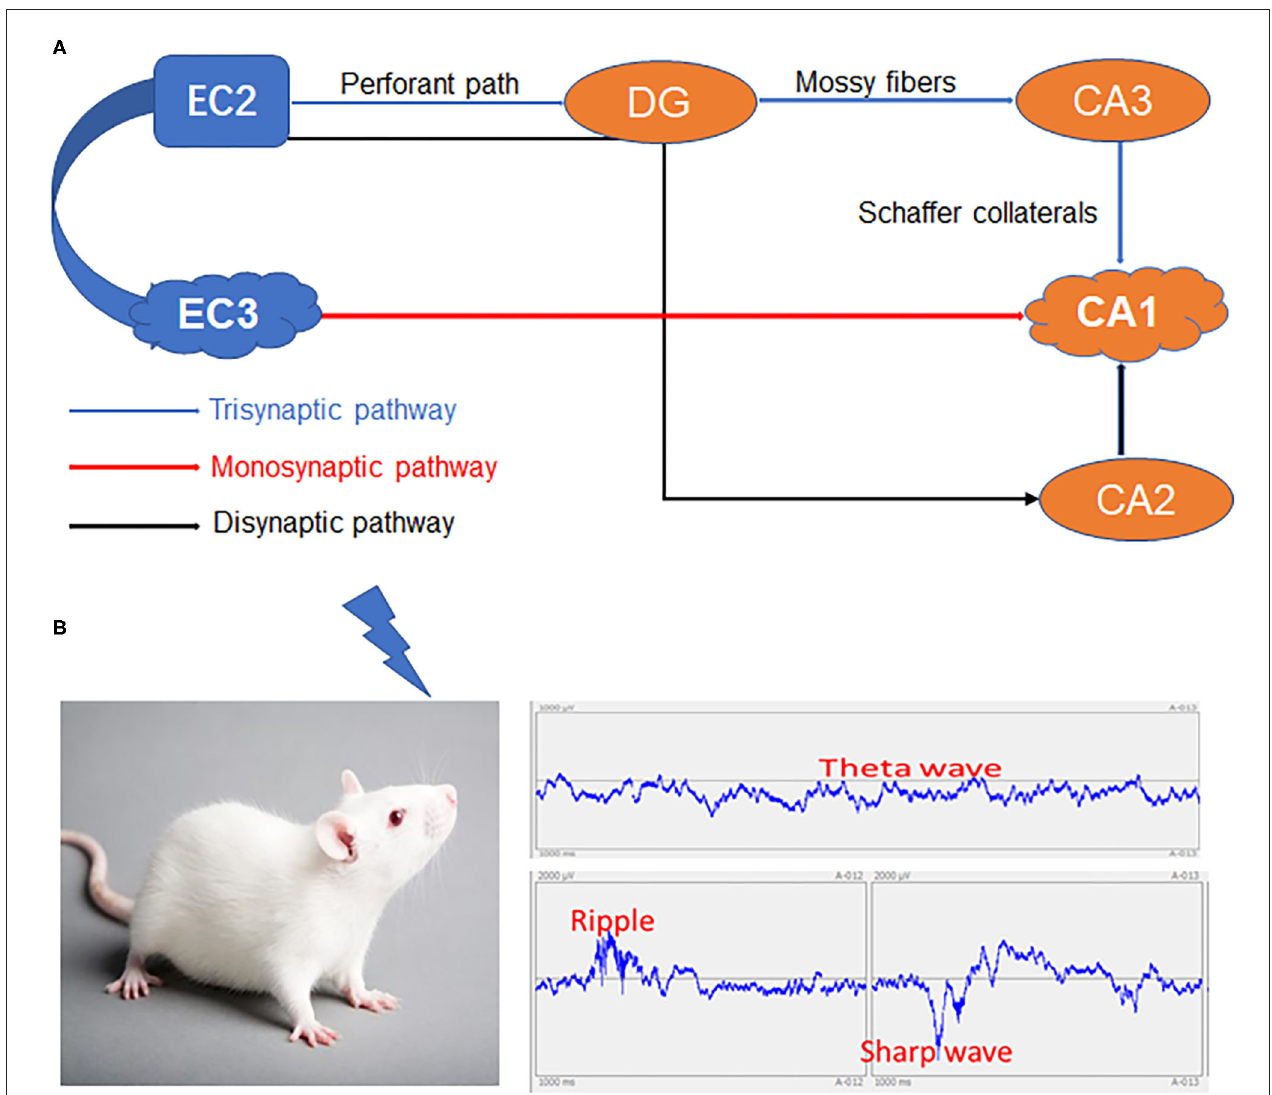
FIGURE 1 | The HPC-EC system and network changes spanning from immediate memory to consolidation. (A) The three major circuits in the hippocampus. (B) Specific inputs to CA1 pyramidal cells in relation to local network oscillations. HPC, Hippocampus; DG, Dentate gyrus; EC2, Entorhinal cortex layer II; EC3, Entorhinal cortex layer III; CA1, CA3, CA2 and DG areas constitute the